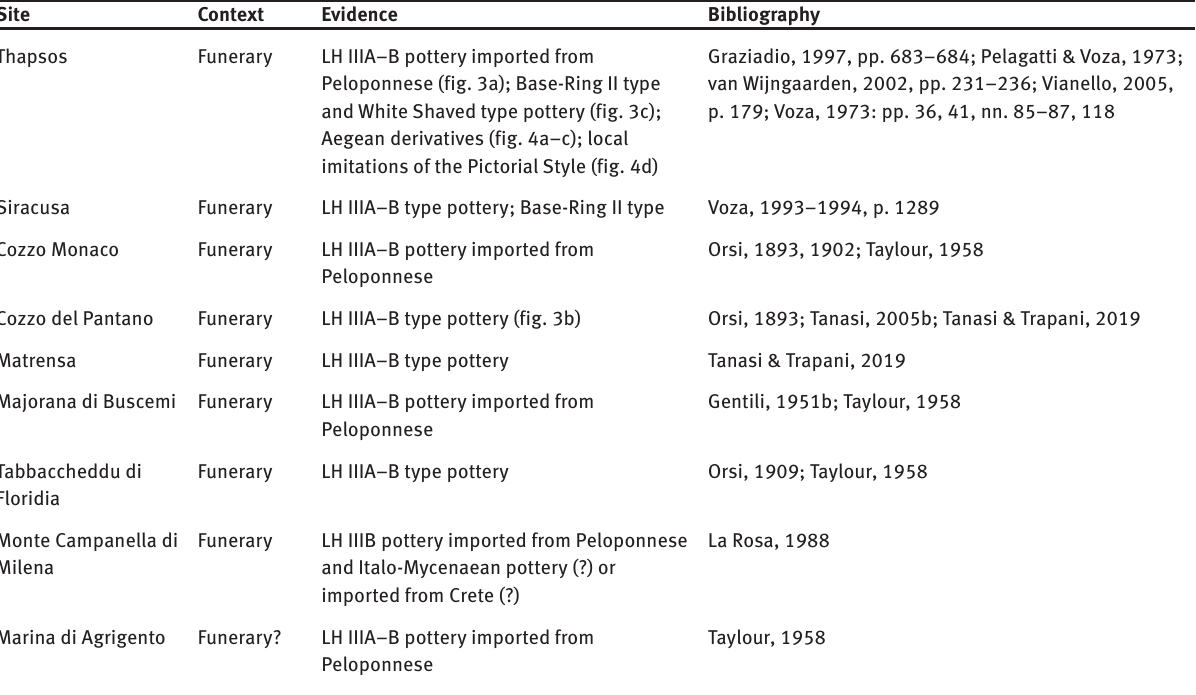
Table 3: Pottery of Mycenaean and Cypriote Origin in Middle Bronze Age Sicily and